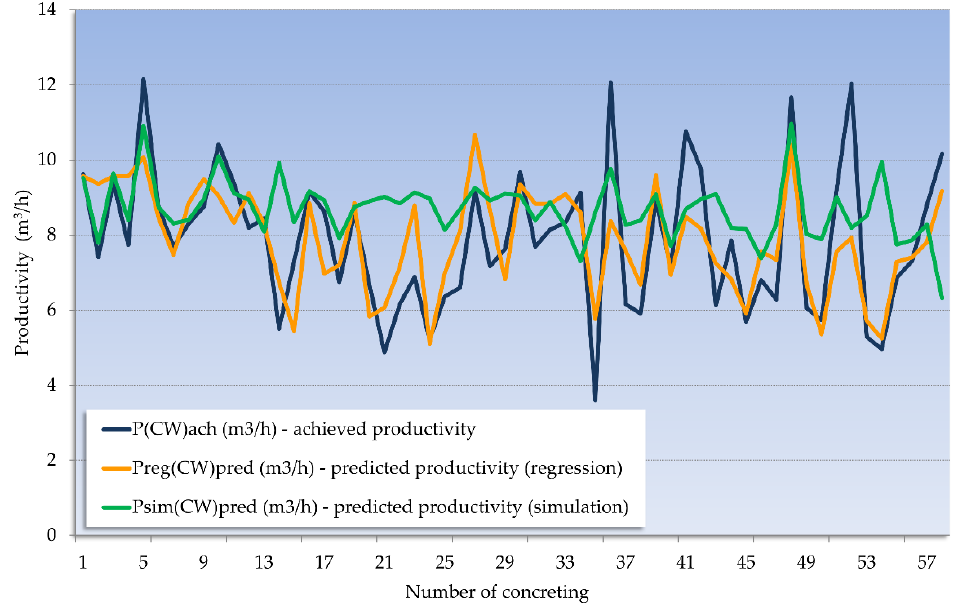
Figure 6. Agreement of achieved productivity with predicted productivity (regression and simula- tion).